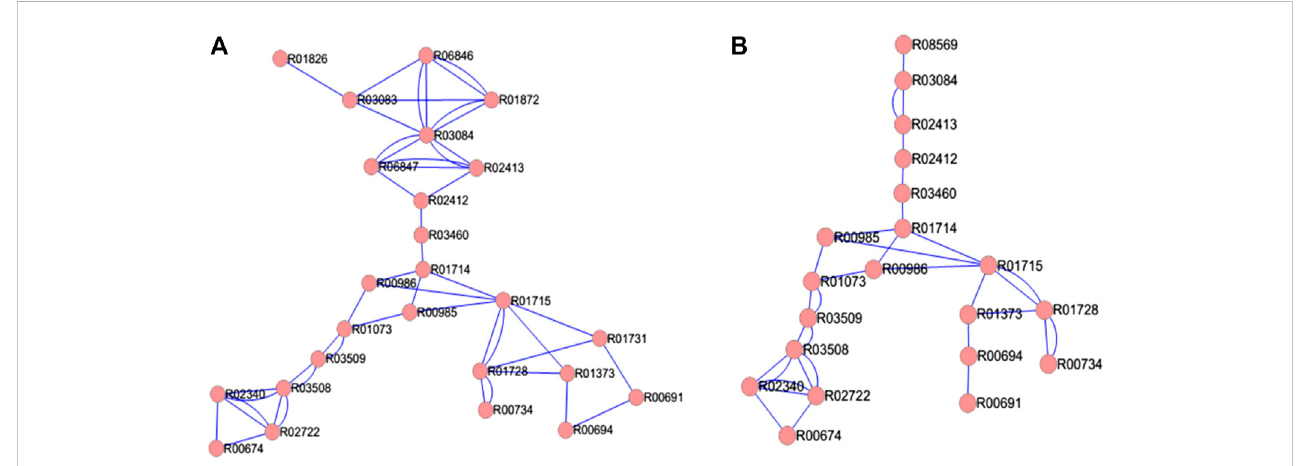
FIGURE 2 TTP network in (A) bacteria E. coli and (B) Archaea N. pharaonis . The double edges indicate reversible reactions.